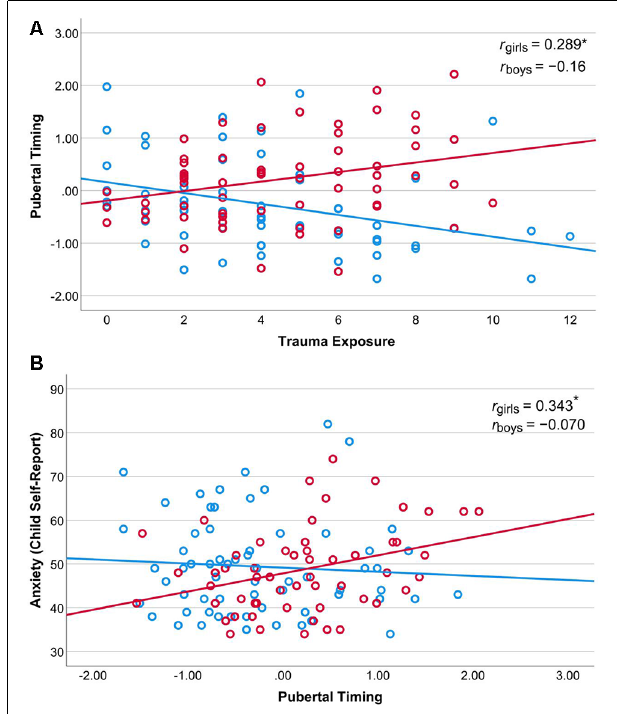
FIGURE 3 | Association between trauma exposure ( x -axis) and pubertal timing (y-axis) for girls and boys (Panel A ). Association between pubertal timing ( x -axis) and anxiety symptoms ( y -axis) for girls and boys (Panel B ). Note : ∗ indicates p <